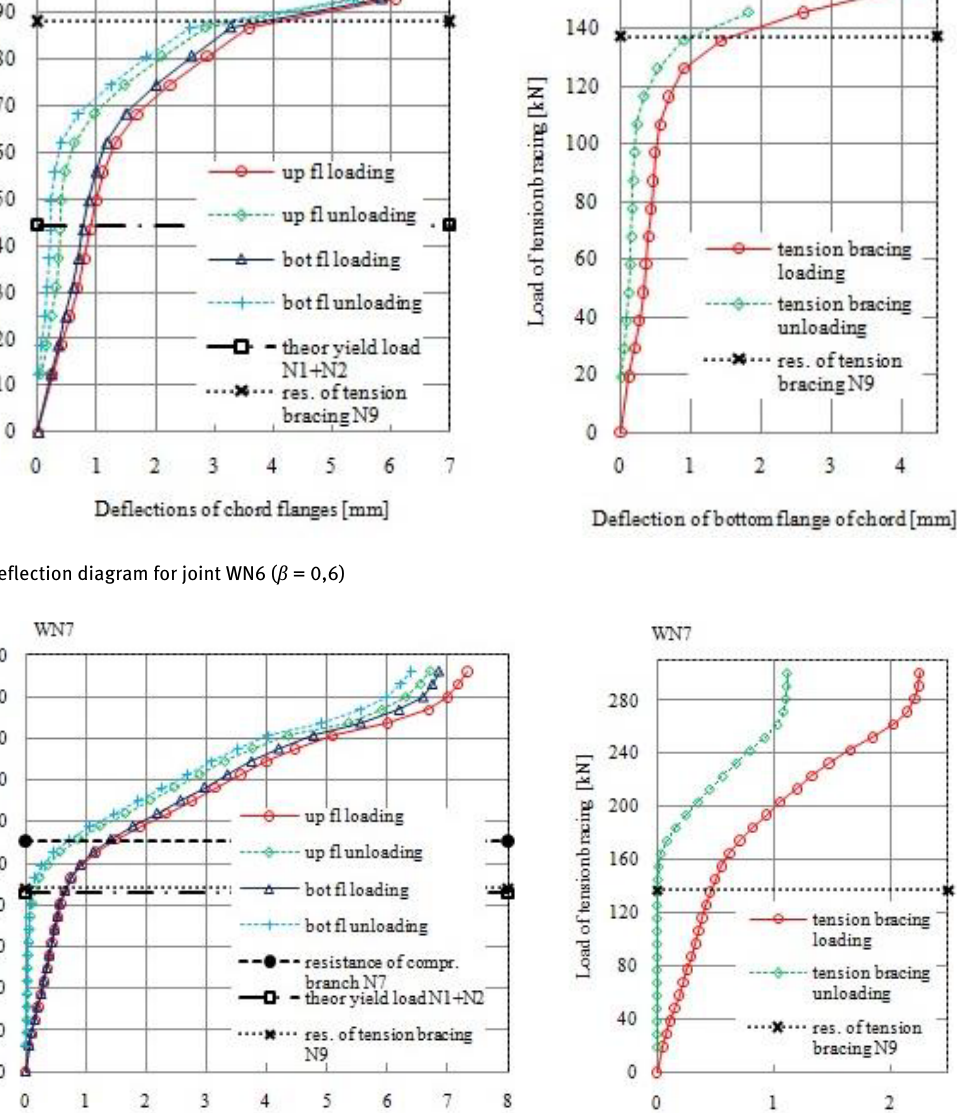
Figure 11: Load-deflection diagram for joint WN7 ( β = 0,6)